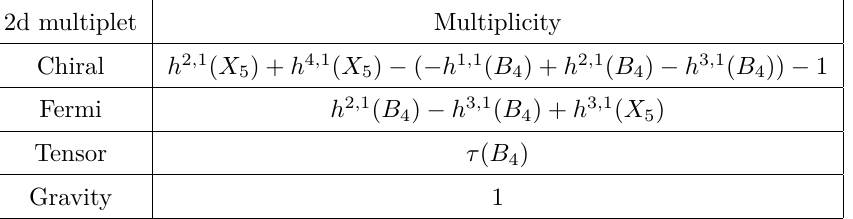
Table 2 . The 2d supermultiplets in the moduli and gravitational sector of F-theory compactification on X 5